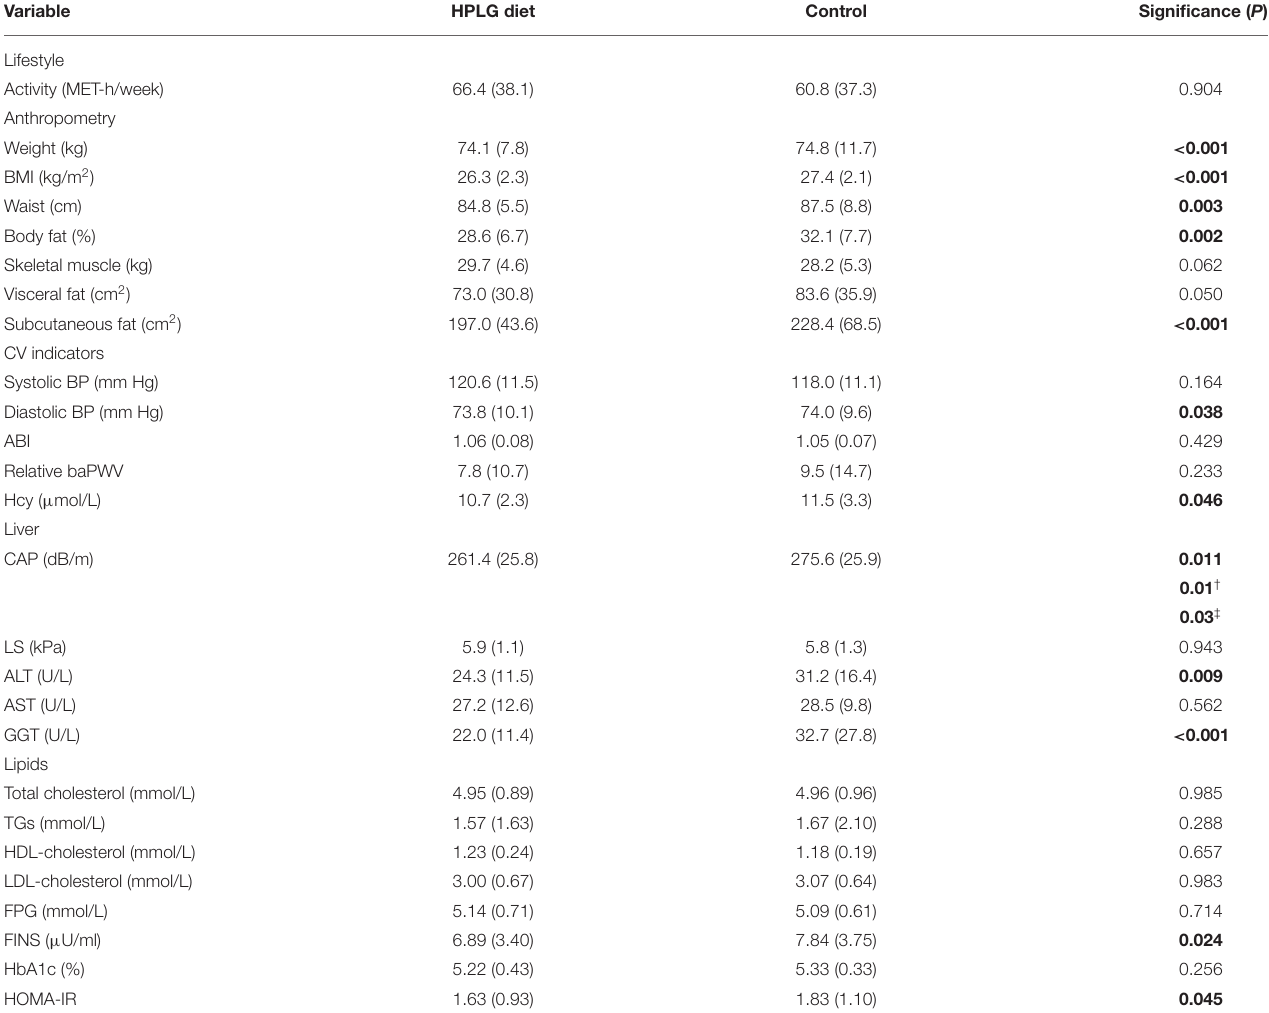
TABLE 3 | Comparison of endpoint results between groups adjusted for baseline values.